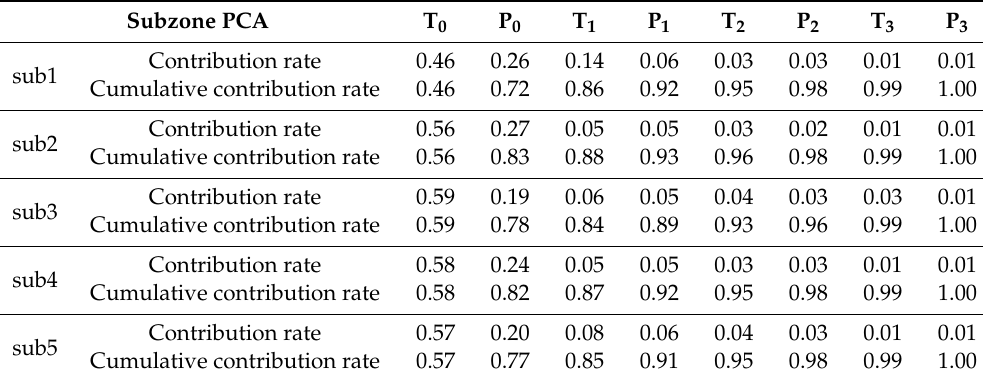
Figure 3. Important factors (rainfall and temperature) in different months. Table 4. Contribution and cumulative contribution rates for selected principal components.